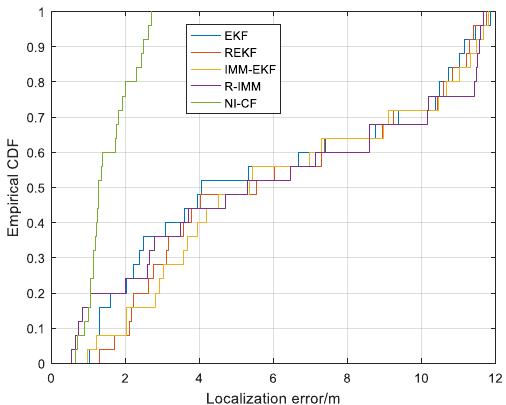
Figure 15. The localization error at each sampling point.